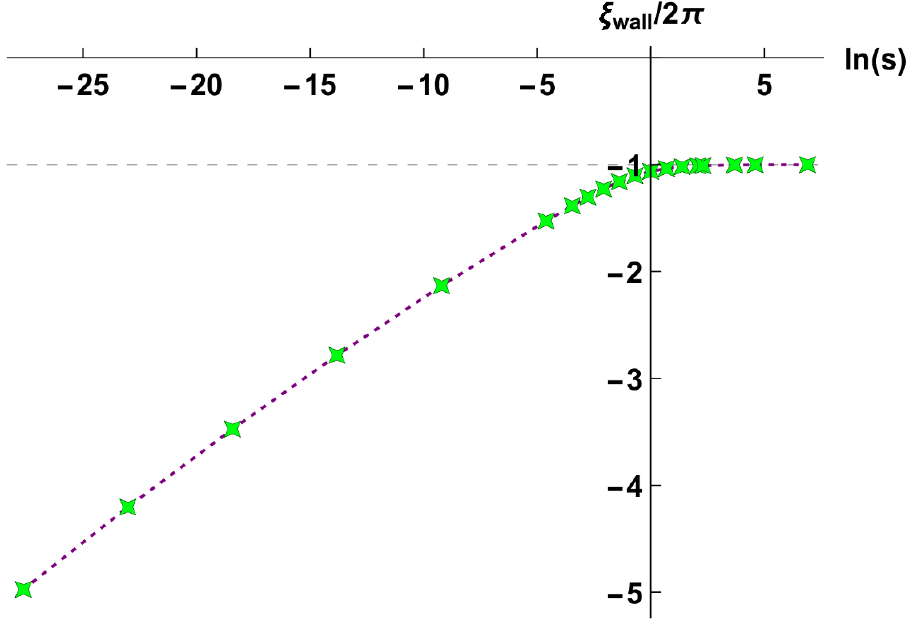
Figure 14 . Location of the wall-of-poles as a function of s . The dashed line indicates the asymptotic value (cid:24) wall = (cid:0) 2 (cid:25)i for s ! 1 . Figure 15 . Borel plane singularities (solid circles) and the QNM frequencies (crosses) at s = 10 (cid:0) 12 (left panel) and s = 1000 (right panel). Red solid circles characterize the location of the wall-of- poles: the wall is relevant for the singularity structure of the Pade approximate of (cid:10) ( B ) range of values of s